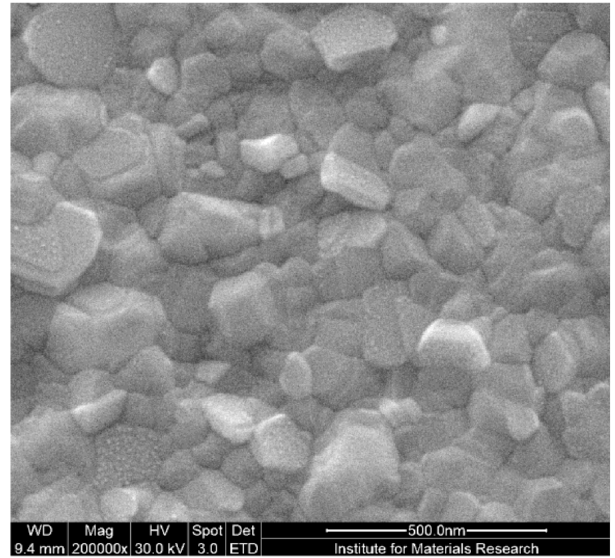
Fig. 7. Perovskite layer morphology after ultrasonic spray coating and gas quenching.